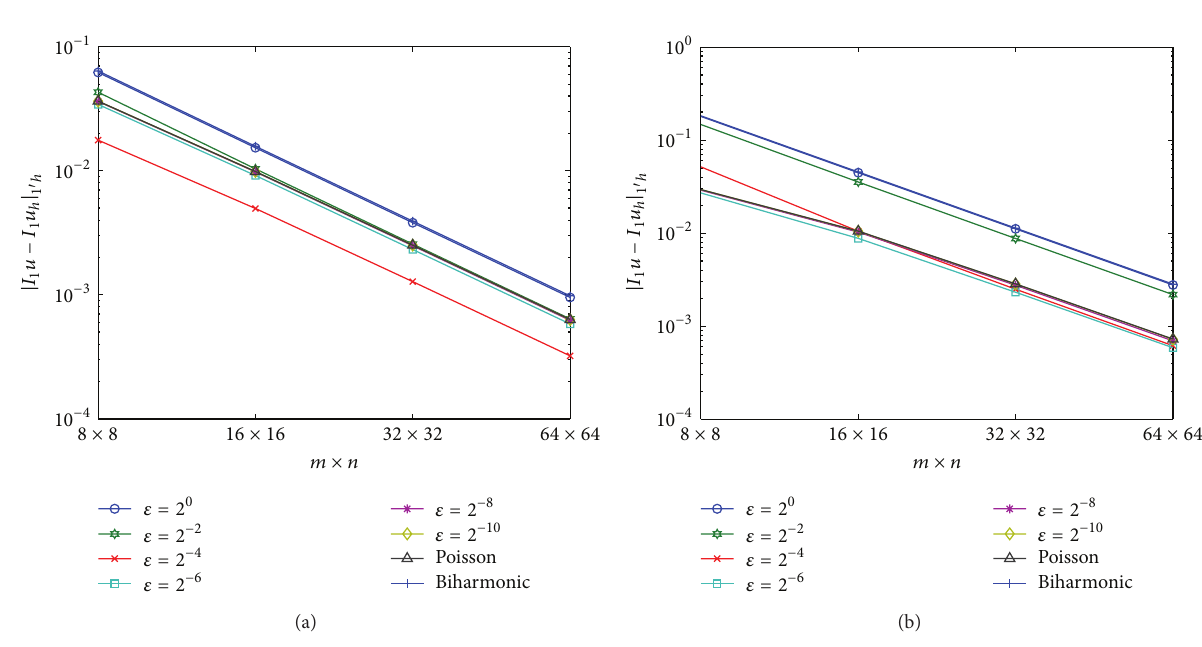
Figure 6: The error |𝑢 − 𝑢 ℎ | 1 under mesh 1 (a) and mesh 2